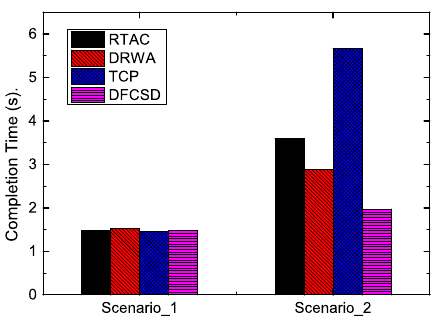
Figure 6. The FCT of the short flow when it competes with a long flow with the size of 10 MB or not. The size of the short flow is 128